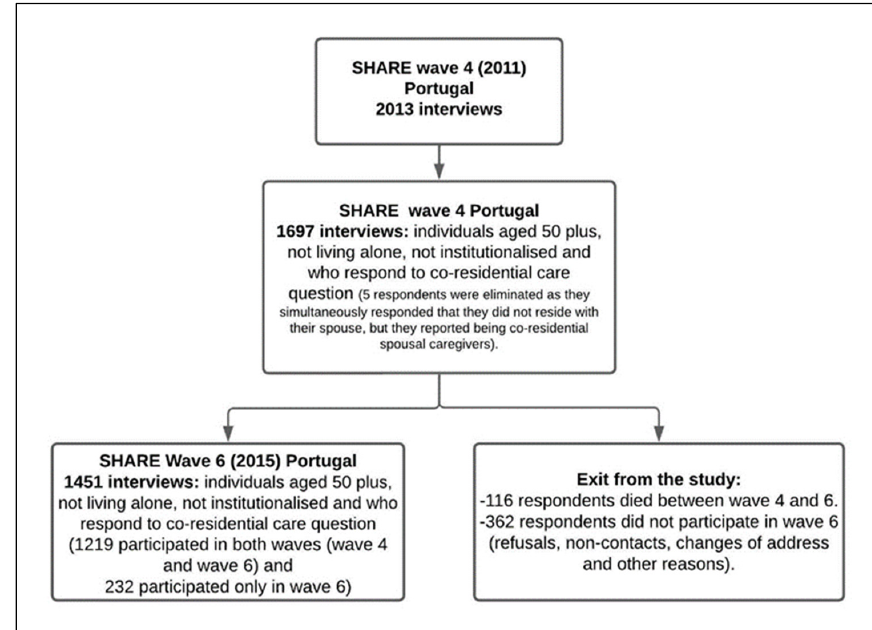
Figure 1. Flowchart outlining the population eligible for this